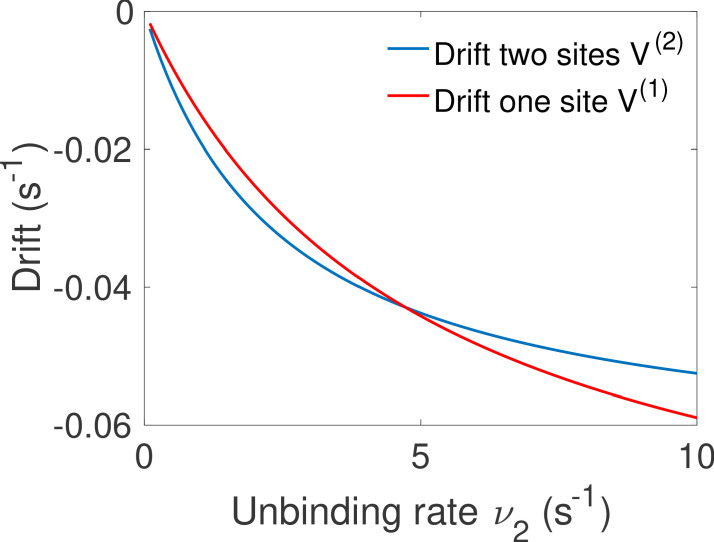
Comparison of the drift for the one and two binding site equilibrium architectures.We compare the drift V(1) of the one binding-site architecture of Main Text Figure 5d and the drift V(2) for the two binding site equilibrium architecture of Main Text Figure 5c. Both have the same parameters L=L2=1⁢μ⁢m-3, L1=1.1⁢μ⁢m-3, μ1=μ2=5⁢μ⁢m3⁢s-1, ν1=5⁢s-1 and we vary ν2. The fastest architecture is the one with the highest absolute value of the drift (lowest on the graph). We recover the transition observed in Main Text Figure 5f between the optimal architectures.